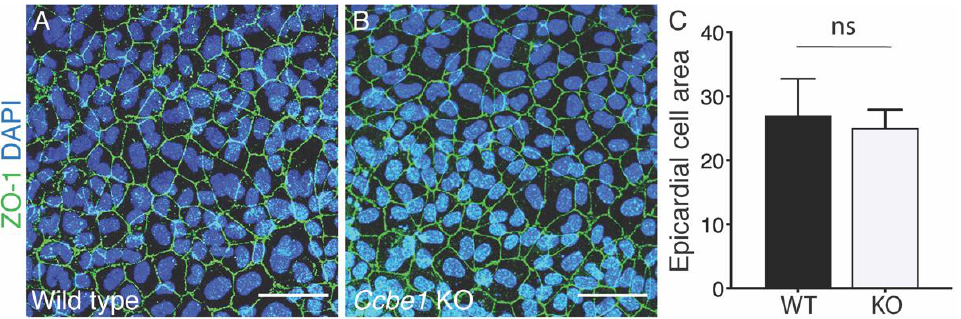
Figure 4. Ccbe1 KO epicardial explants show normal size, morphology, and ZO-1 localization. ( A , B ) epicardial explants immunostained for ZO-1 antibody. Images are representative of the following number of replicates: wild-type, n = 12; mutant, n = 12. ( C ) Quantification shows no significant differences in epicardial cell areal. ns, non significant. Scale bars = 50 μm.